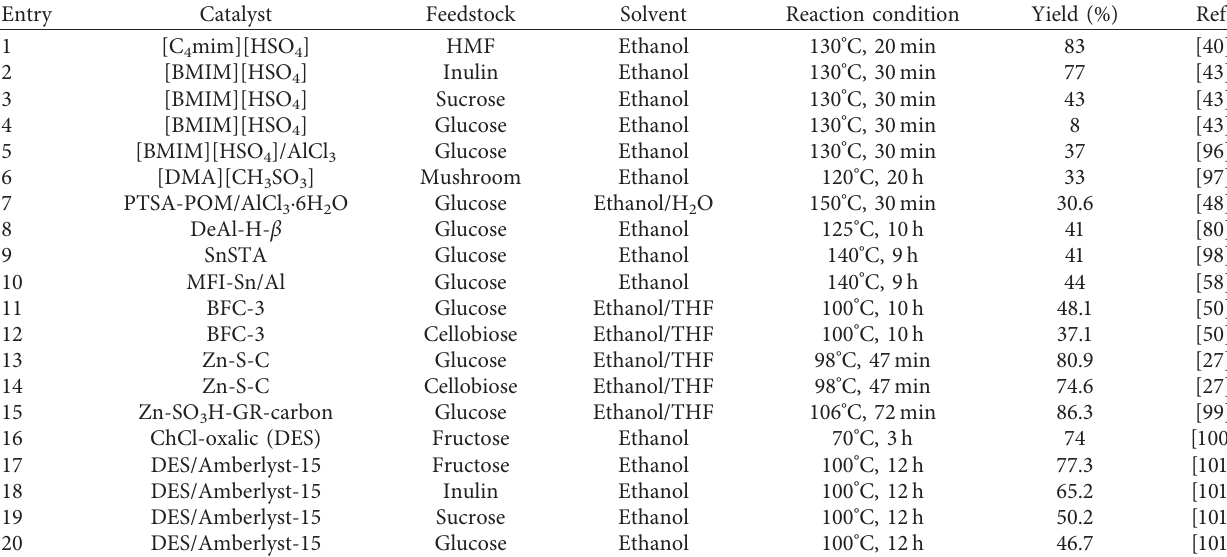
Table 4: Ionic liquid, mixed-acid catalyst, and deep eutectic solvents used for EMF synthesis.